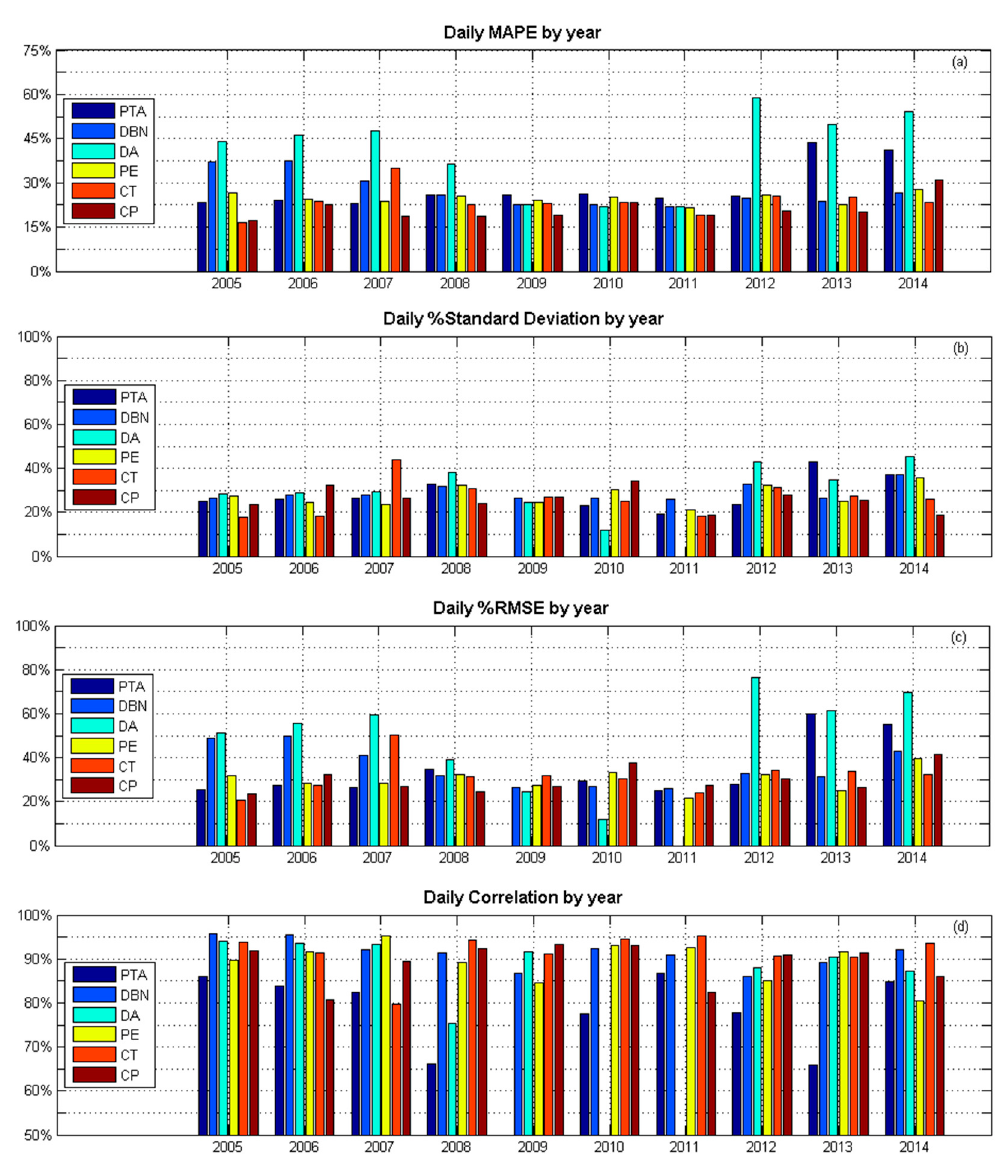
Figure 9. Year-on-year validation statistics for daily clear sky satellite overpass time UV index values at each of the six sites: Cape Point (CP), Cape Town (CT), Durban (DBN), De Aar (DA), Port Elizabeth (PE), and Pretoria (PTA), where ( a ) shows the daily MAPE by year; ( b ) the daily percentage standard deviation by year; ( c ) daily percentage RMSE; and ( d ) daily percentage correlation by year.